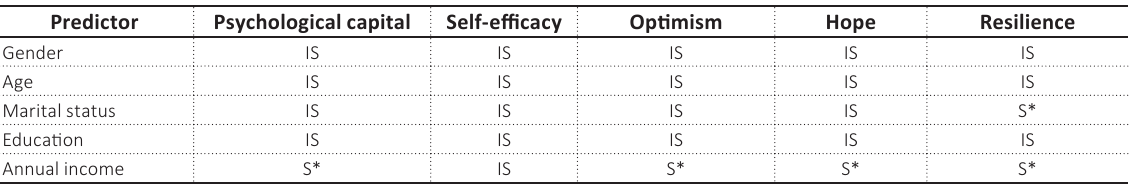
Source: Analysis of survey data.